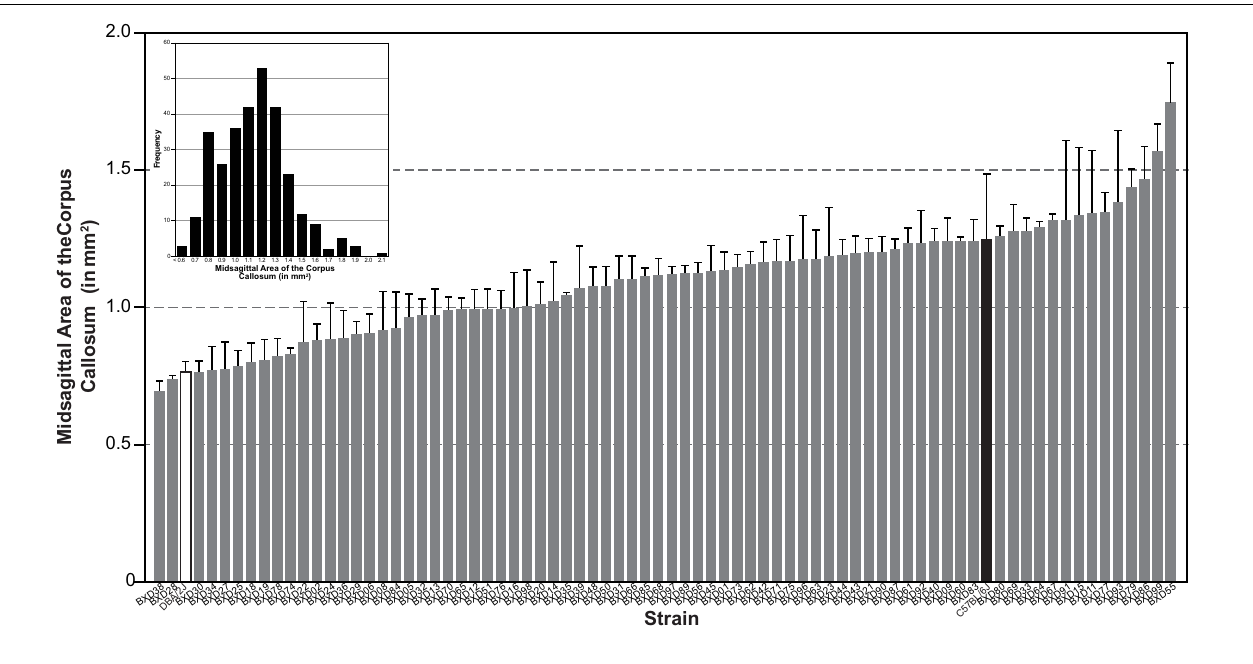
FIGURE 1 | Histogram of mean ( ± SEM) MSACC in 76 BXD strains (gray bars) and in the two parentals: DBA/2J (white bar) and C57BL/6J (black